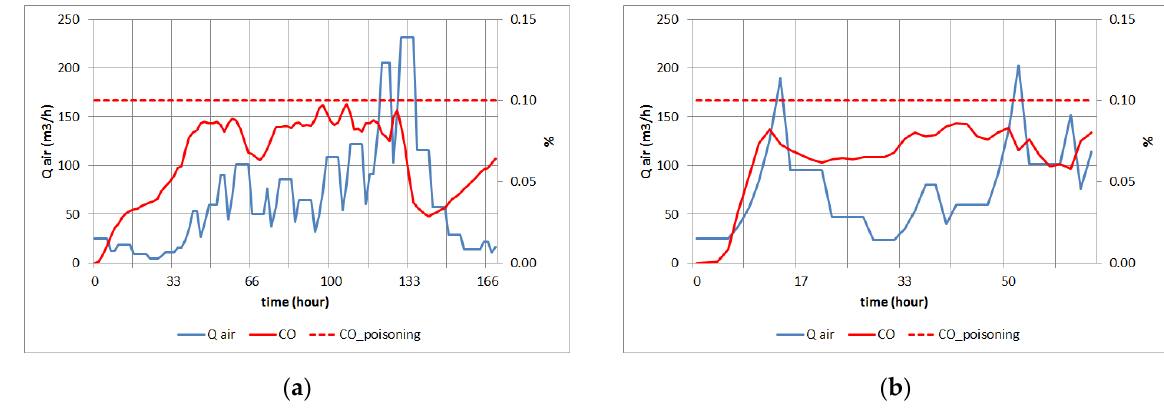
Figure 12. The behavior of CO with using control algorithm ( a ) experiment #3 ( b ) experiment #4.